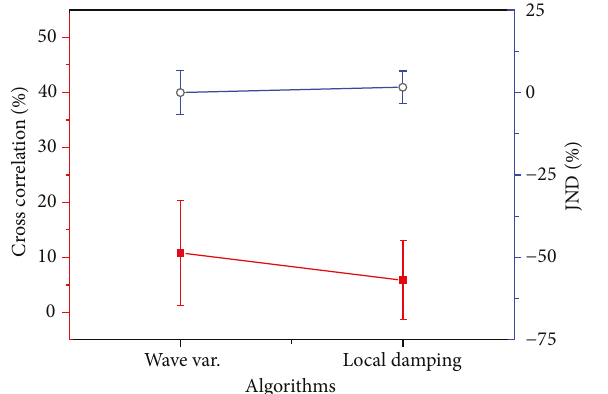
Figure 19: Maneuverability performance and perceptual sensitivity.